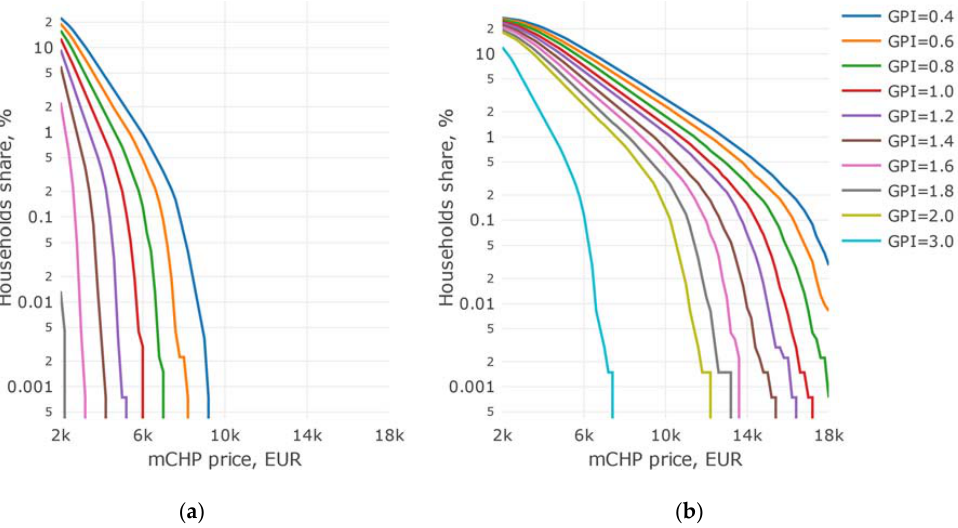
Figure 15. The household share (log scale) for: ( a ) EPI = 1.0 and different GPI; ( b ) EPI = 3.0 and different GPI.